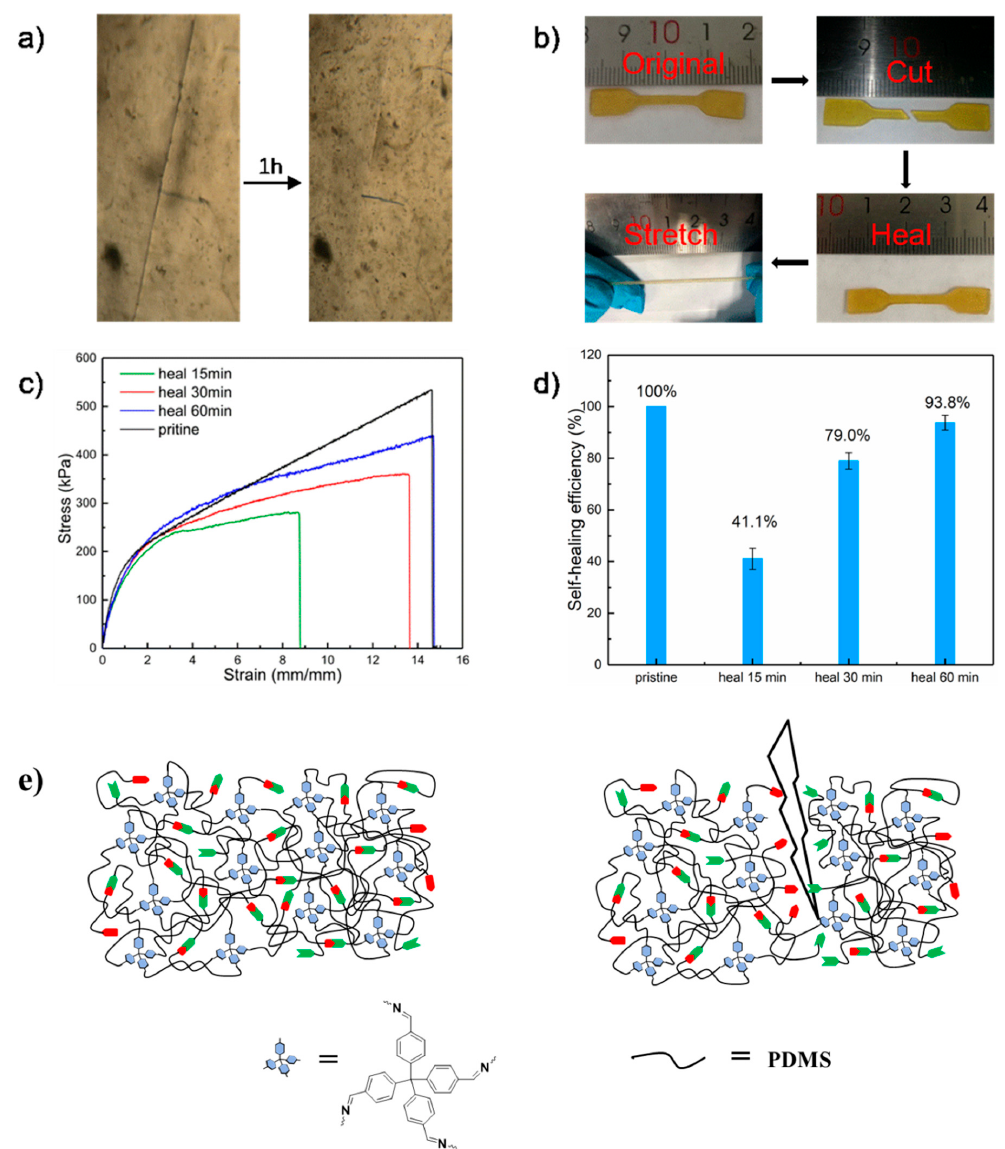
Figure 4. ( a ) Photographs illustrating the macroscopic cutting-healing-stretching procedure of TFPM- PDMS-25000 films at 25 °C. ( b ) Photographs illustrating the macroscopic cutting-healing-stretching procedure of TFPM-PDMS-25000 films at 25 °C. ( c ) Uniaxial tensile tests and ( d )